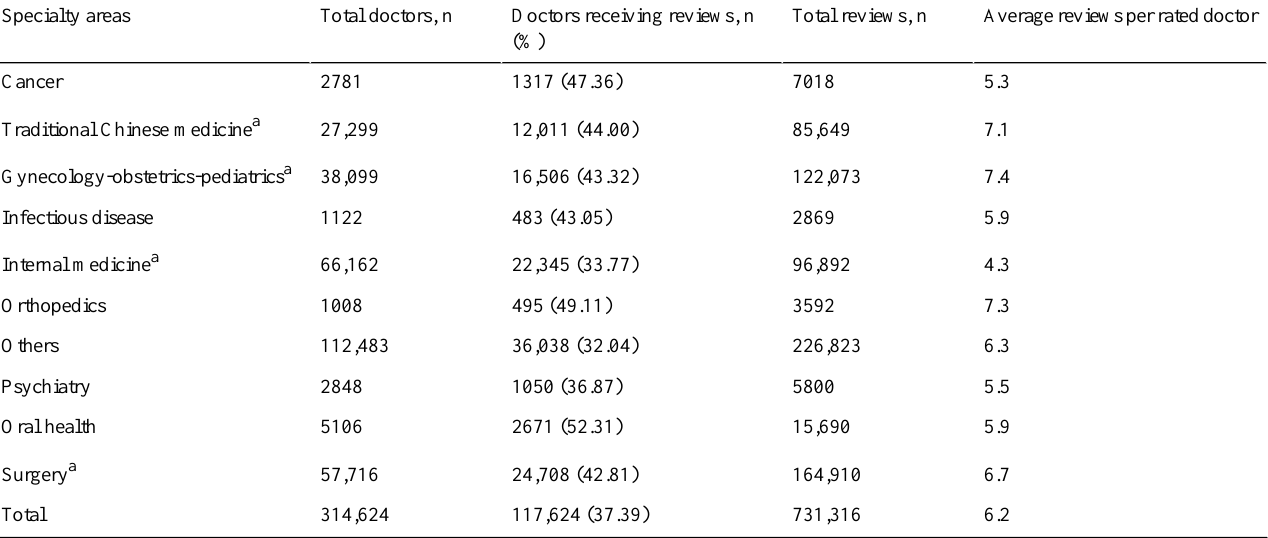
Table 1. Specialty areas, number of doctors, and number of reviews from the Good Doctor website.